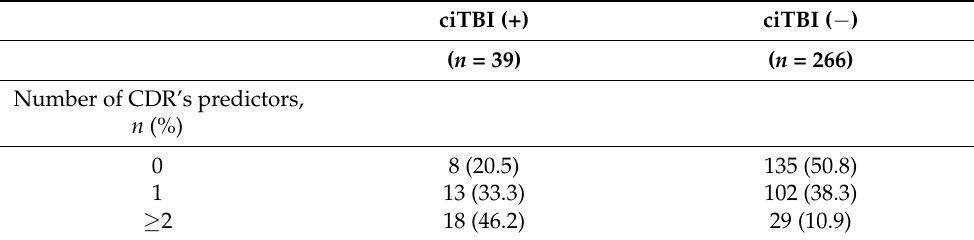
Table 5. Association between the number of applicable predictors in simplified CDR and